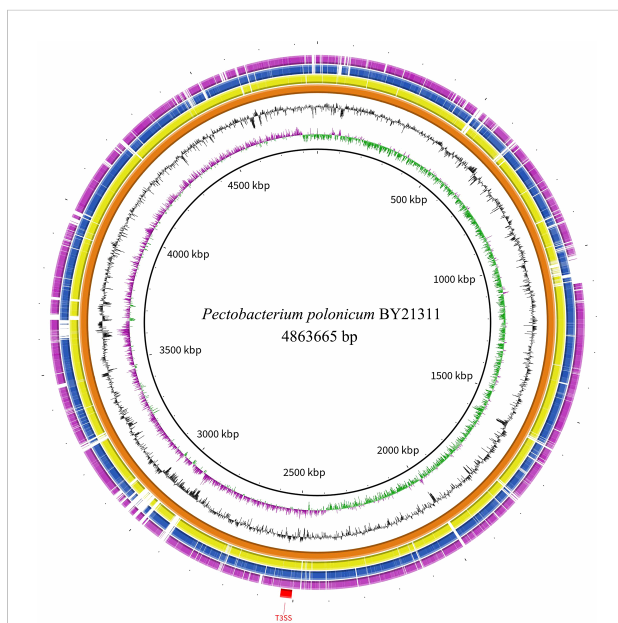
FIGURE 5 Circular representation of genome sequences of the Pectobacterium polonicum isolate BY21311, P. polonicum type strain DPMP315 T , P. punjabense type strain SS95 T , and P. brasiliense type strain LMG21371 T . The rings represent (from inner to outer) GC skew, GC%, the whole genome sequence of isolate BY21311, corresponding homologous regions in P. polonicum DPMP315 T , P. punjabense SS95 T and P. brasiliense LMG21371 T , and the genome region encoding type III secretion system (T3SS). Genome comparison was created using BRIG